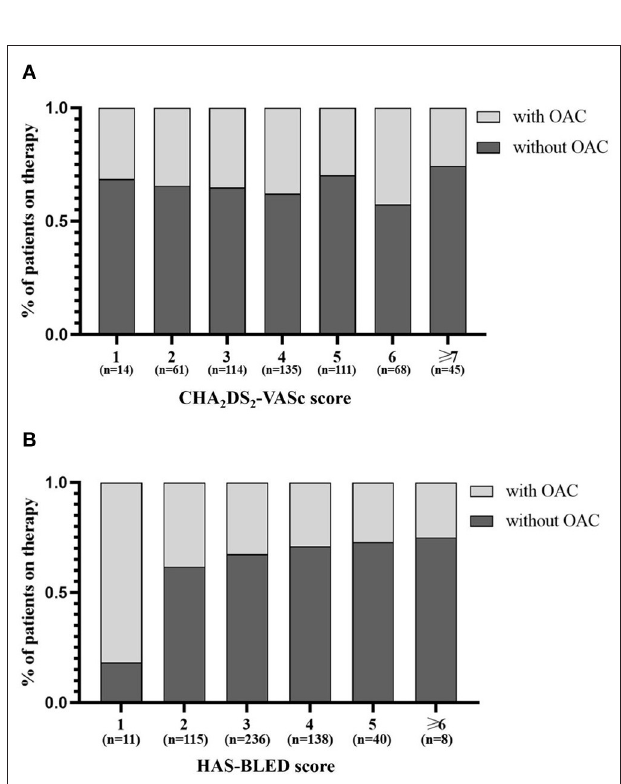
is mainly affected by the risk of bleeding. (2) The